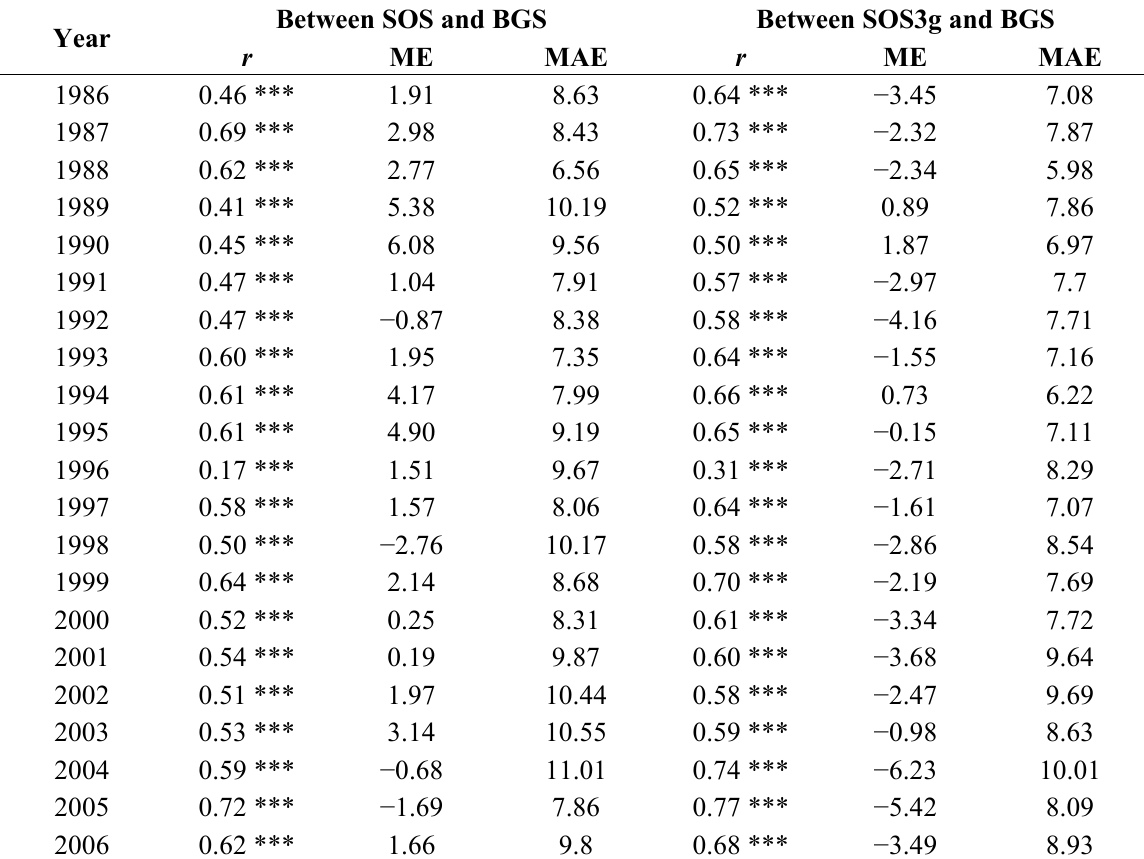
Table 1. Spatial correlation coefficients ( r ), mean error (ME) and mean absolute error (MAE) between SOS (SOS3g) and BGS at all pixels in each year (n = 3,994). Between SOS and BGS Between SOS3g and BGS Year r ME MAE